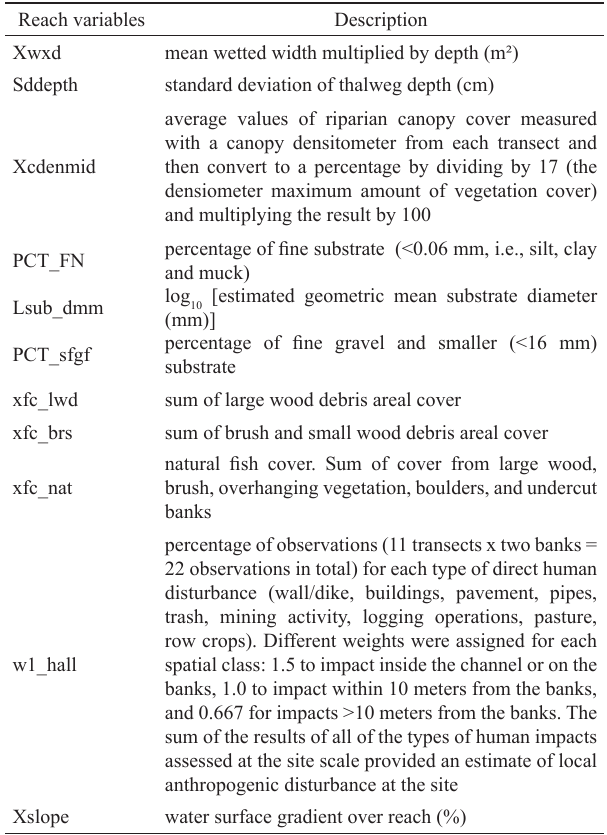
Table 1. Descriptions of 11 site attributes represented for acronyms according to Kaufmann et al .